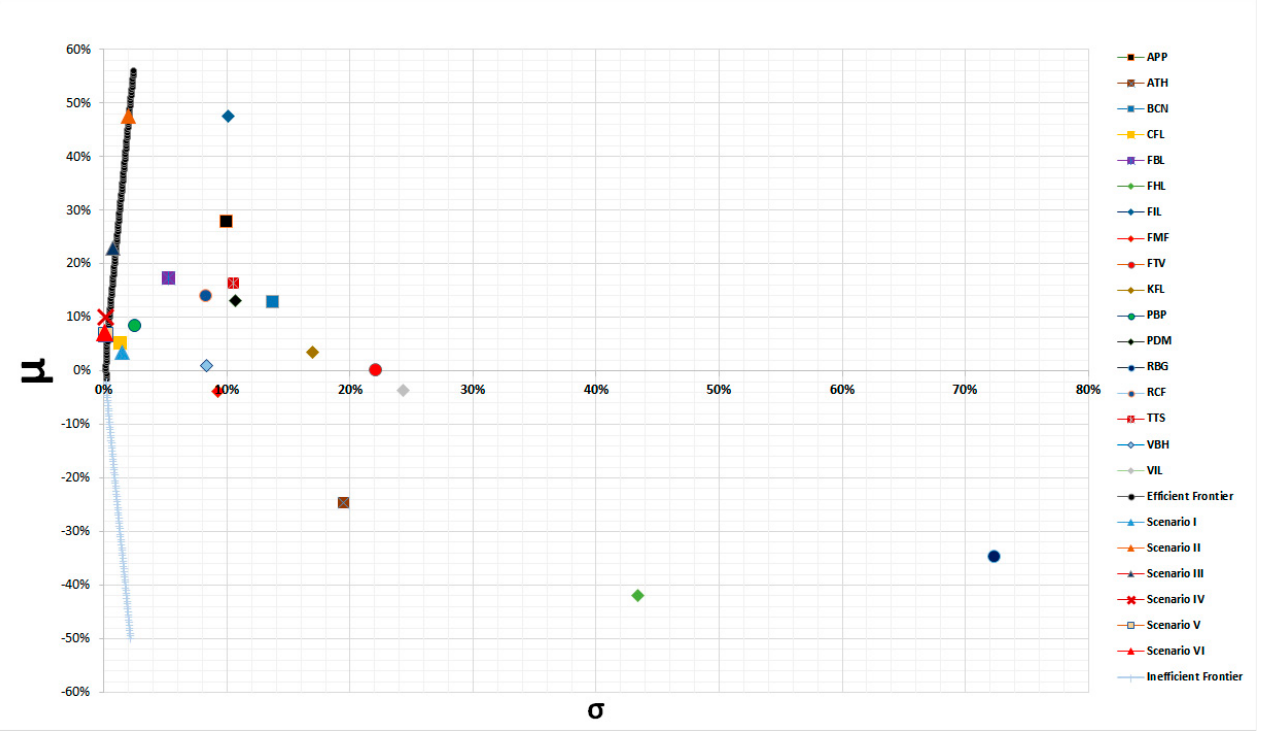
Figure 7. Plot of Stock and Portfolio Risk-Returns and Efficient Frontier Based on Semi–Variance Analysis. Source: Authors’ calculations based on the monthly returns data from SEP-2019 to